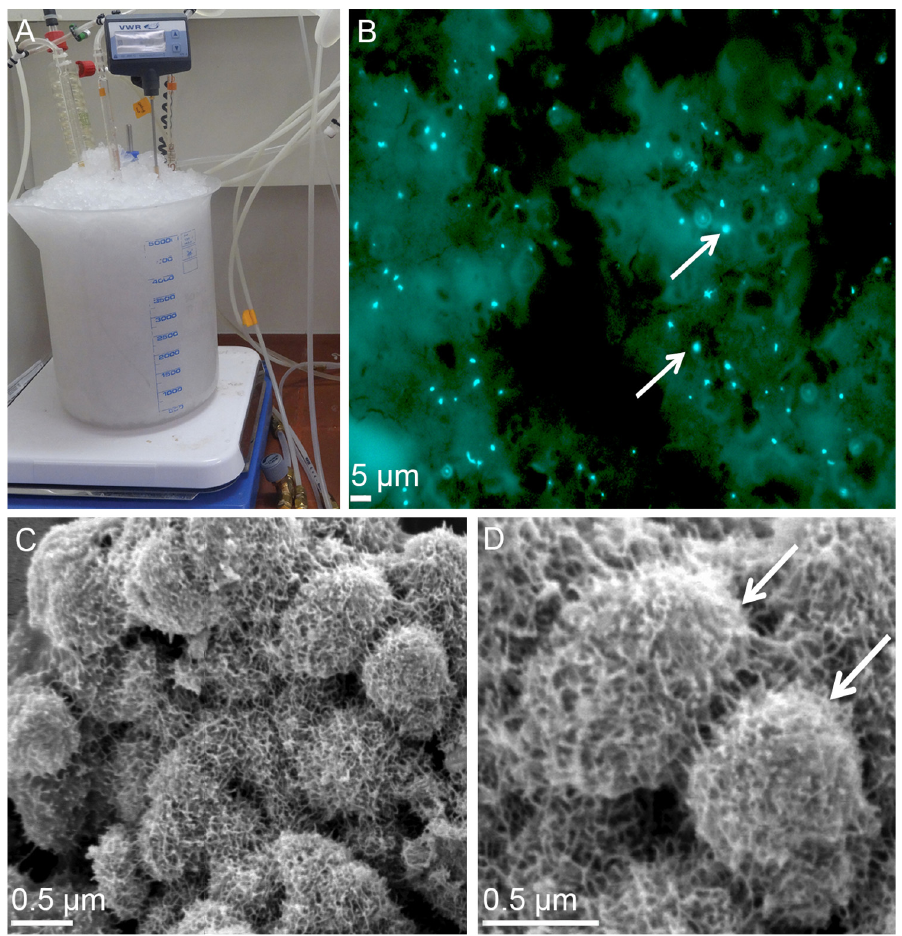
Figure 2. The cultivation of M. sedula cells with the stony meteorite NWA 1172 as the sole energy source at the cold temperature regime. ( A ) The cultures of M. sedula at low temperature in 1 L glassblower modified Schott ‐ bottle bioreactors. M. sedula cultures were incubated at the average temperature of 12 °C in an ice ‐ supplemented environment (modified from Milojevic et al. [41]). ( B ) The multi ‐ labeled fluorescence in situ hybridization (MiL ‐ FISH) of M. sedula cells supplemented with the stony meteorite NWA 1172 as the sole energy source at low temperature. An overlaid epifluorescence image shows overlap of specific probe with DAPI signals (modified from Milojevic et al. [26]). Cultures of M. sedula were examined with MiL ‐ FISH [78,83] following 2 months of culti ‐ vation at 12 °C. ( C ) A scanning electron microscopy (SEM) image of M. sedula supplemented with the stony meteorite NWA 1172 as the sole energy source at low temperature. ( D ) A higher magnifi ‐ cation SEM image displaying single cells of M. sedula covered with extracellular matrix. Cells of M.